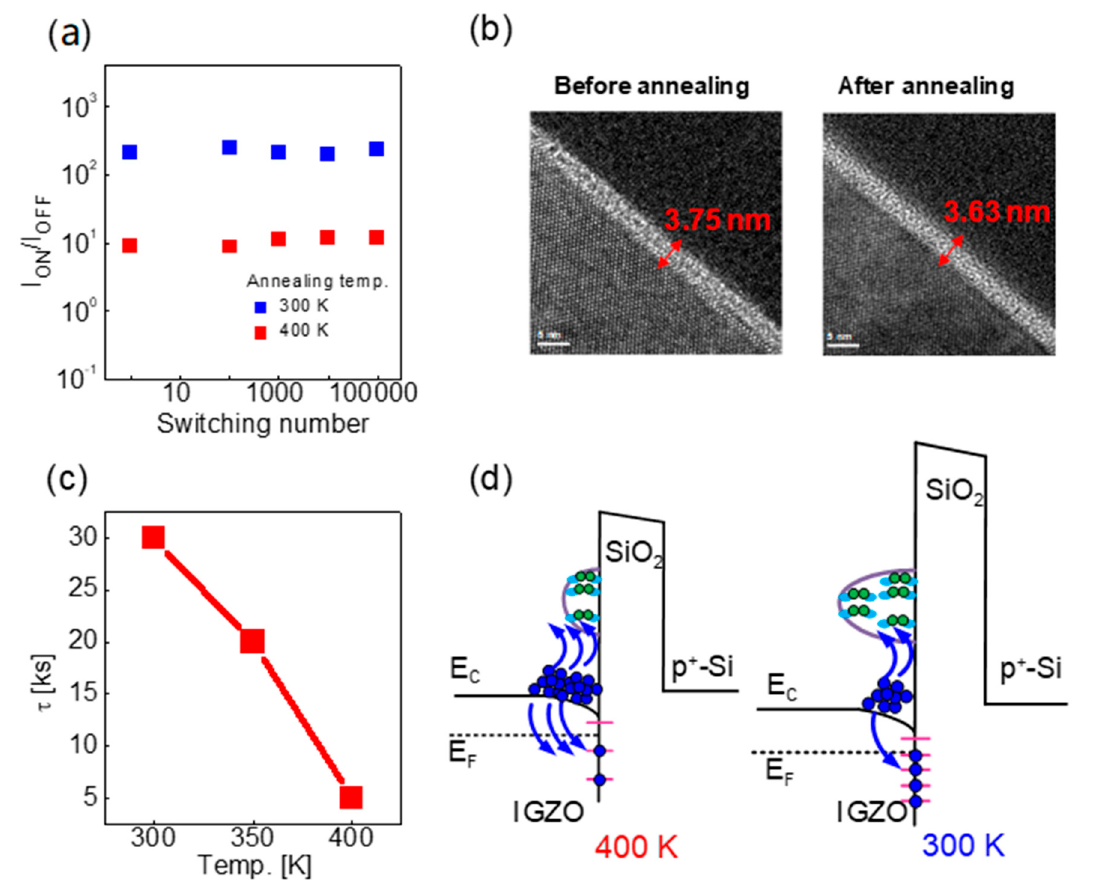
Figure 7. ( a ) On/off ratio as a function of switching number in devices based on annealing tempera- ture (300 K and 400 K); ( b ) TEM images of samples before and after annealing; ( c ) τ vs. annealing temperature; and ( d ) EBD, including oxygen vacancies and trapping of electrons for the explanation of retention.